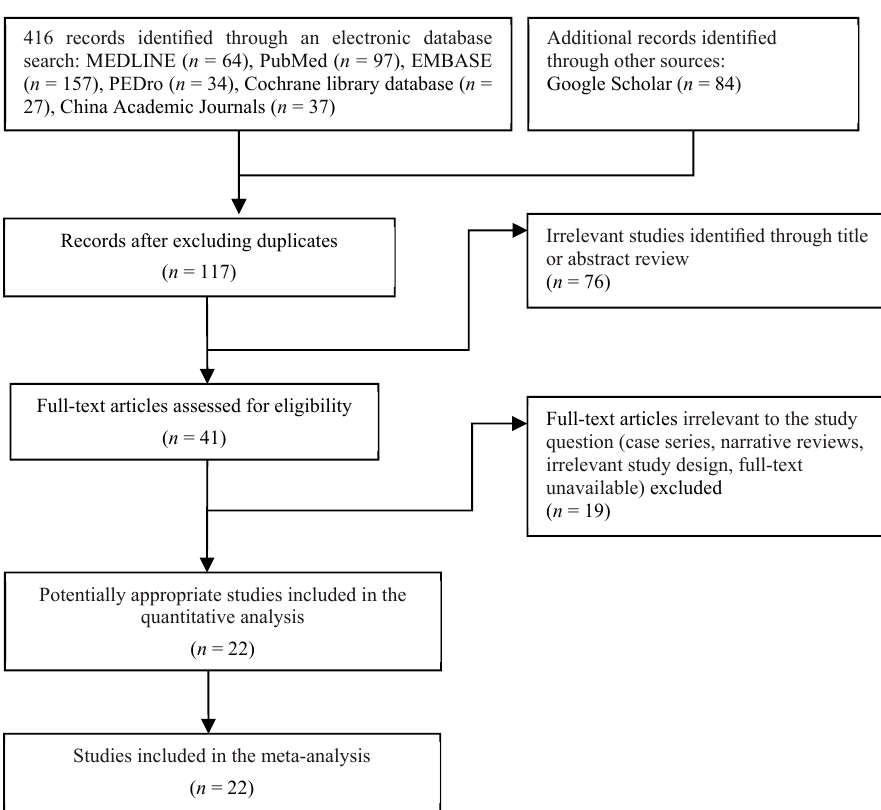
Figure 1. Flowchart of the study selection process.